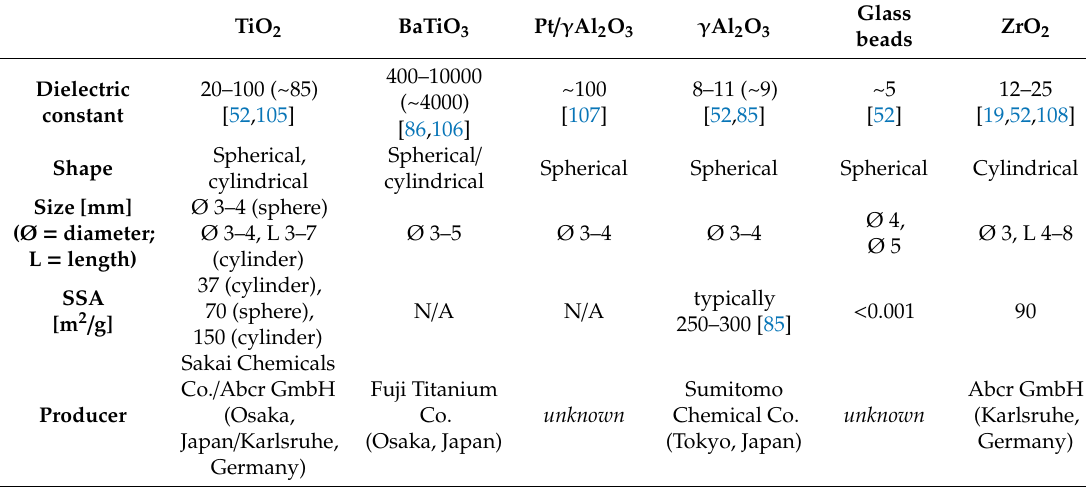
Table 2. Properties (dielectric constant, shape, size, specific surface area (SSA) and producer) of used packing materials (N / A = not